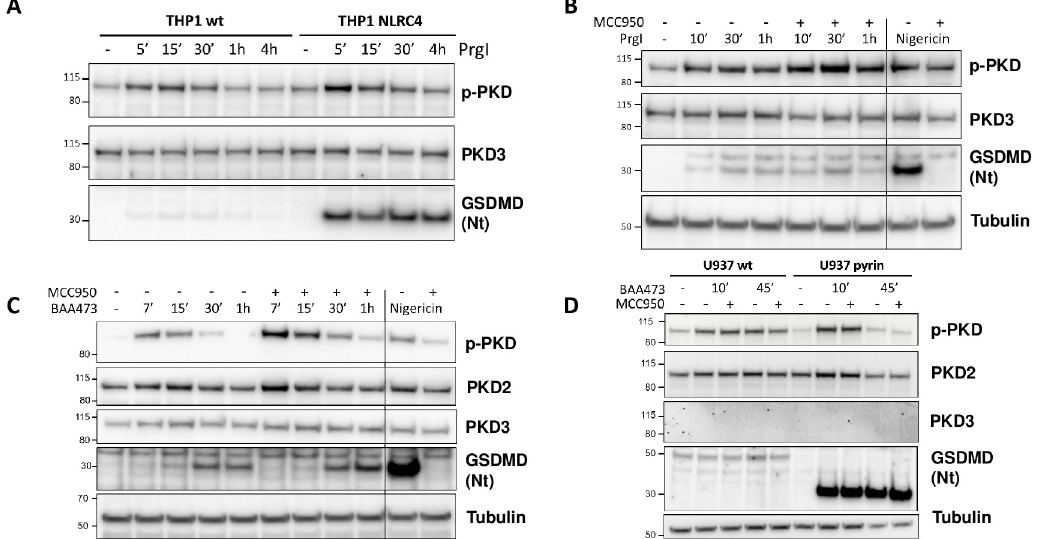
Fig 4. PKD auto-phosphorylation is not a selective inflammasome marker. (A) Time course of stimulation of THP1-WT and THP1-NLRC4 cells upon stimulation with PrgI (3 μ g/ml). Immunoblot analysis of whole cell lysates showing total and auto- phosphorylated PKD, as well as gasdermin D cleavage. (B) Time course of stimulation of THP1-WT with PrgI (3 μ g/ml) ± MCC950 (10 μ M). Nigericin stimulation ± MCC950 (10 μ M) serves as positive control. Immunoblot analysis of whole cell lysates showing total and auto-phosphorylated PKD, as well as gasdermin D cleavage. Tubulin levels are used for comparison of PrgI and nigericin stimulatory conditions. (C) Time course of stimulation of THP1-WT with BAA473 (100 μ M) ± MCC950 (10 μ M). Nigericin stimulation ± MCC950 (10 μ M) serves as positive control. Immunoblot analysis of whole cell lysates showing total PKD2/3 levels and auto-phosphorylated PKD, as well as gasdermin D cleavage. Tubulin levels are used for comparison of BAA473 and nigericin stimulatory conditions. (D) Time course of stimulation of U937-WT and U937-Pyrin cells with BAA473 (100 μ M) ± MCC950 (10 μ M). Immunoblot analysis of whole cell lysates showing total PKD2/3 levels and auto-phosphorylated PKD, as well as gasdermin D cleavage. Lower tubulin levels in pyrin-overexpressing cells at 45 min account for cell death triggered by BAA473.